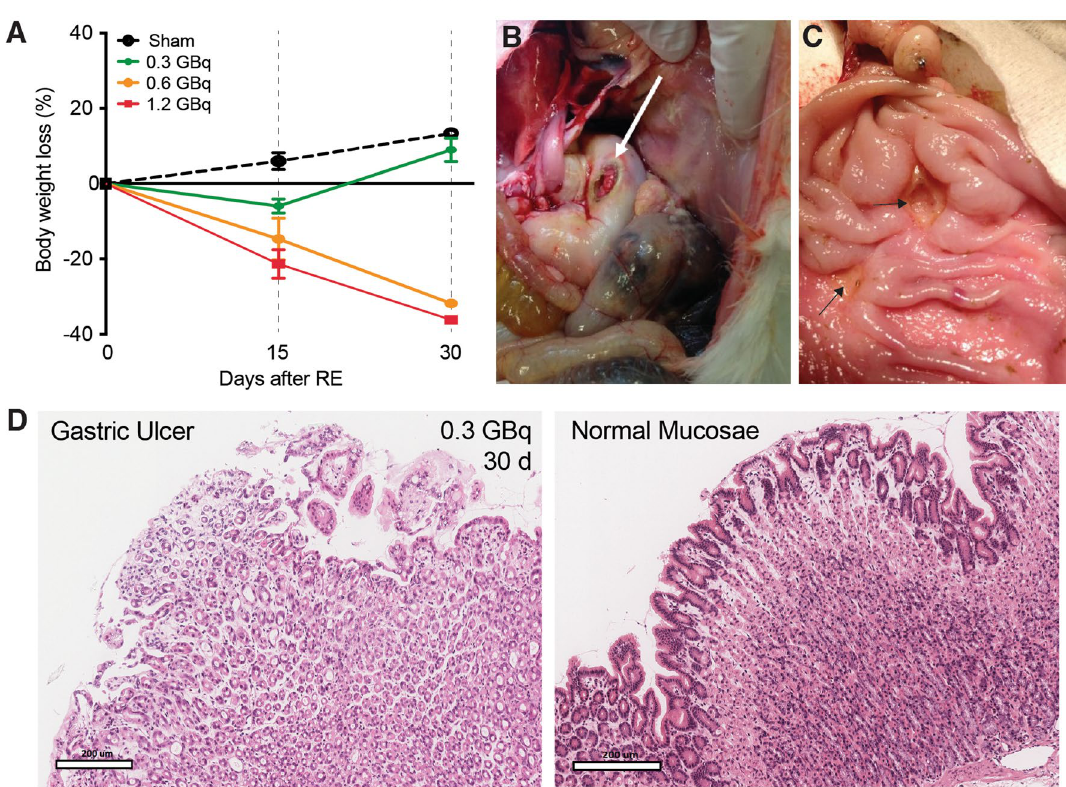
Figure 3. Extrahepatic toxicity of CrLs SIRT. ( A ) Body weight in different groups along the time. ( B ) Gastric mucosal ulceration with perforation (white arrow) 30 days after 0.6 GBq injection. ( C ) Superficial gastric ulcers (black arrows) in the vicinity of the irradiated CrLs 30 days after 0.3 GBq injection. ( D ) Hematoxylin & Eosin- stained sample a normal gastric mucosae and a subverted mucosae from a gastric ulcer 15 days after